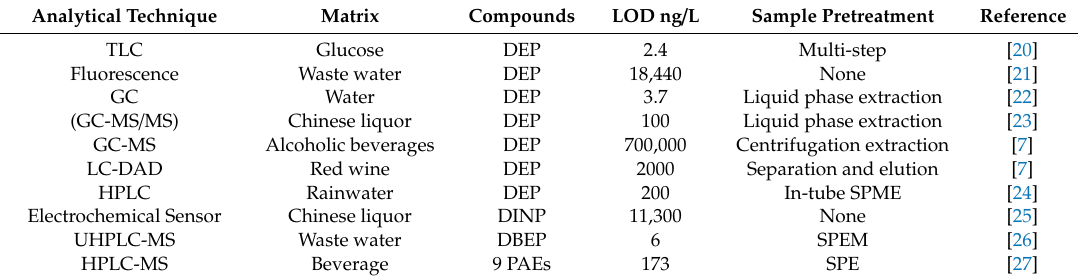
Table 1. Summary of literature methods aimed at phthalates ester (PAEs) determination. Analytical